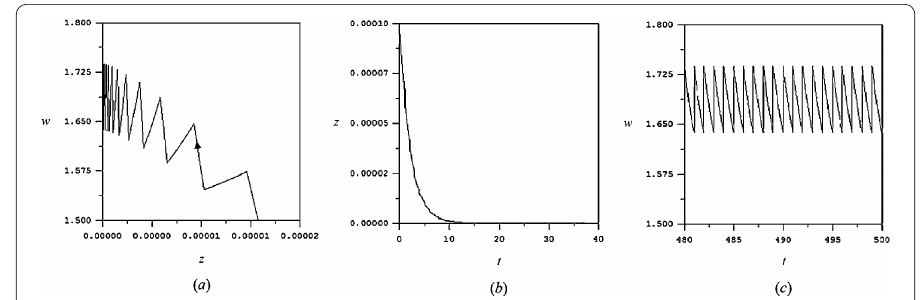
Figure 1 Numerical simulation of equations (4a)-(4d). The solution trajectory approaches oscillatory solution (0, ˜ w ( t )) as time passes. Here, all parameters are chosen to satisfy the conditions in Theorem 1, i.e., a 1 = 0.65, a 2 = 0.3, a 3 = 0.3, a 4 = 0.9, a 5 = 0.1, b 1 = 0.5, b 2 = 0.2, b 3 = 0.425, b 4 = 0.5, k 1 = 0.1, k 2 = 0.5, k 3 = 0.1, k 4 = 0.5, k 5 = 0.01, k 6 = 0.75, μ = 0.1, ρ = 0.1, T = 1, z (0) = 0.0001, and w (0) = 0.0001. (a) The solution trajectory projected on ( z , w )-plane. (b) The corresponding time course of the number of active osteoclasts ( z ) tending towards zero. (c) The corresponding time course of the number of active osteoblasts ( w ) exhibiting positive